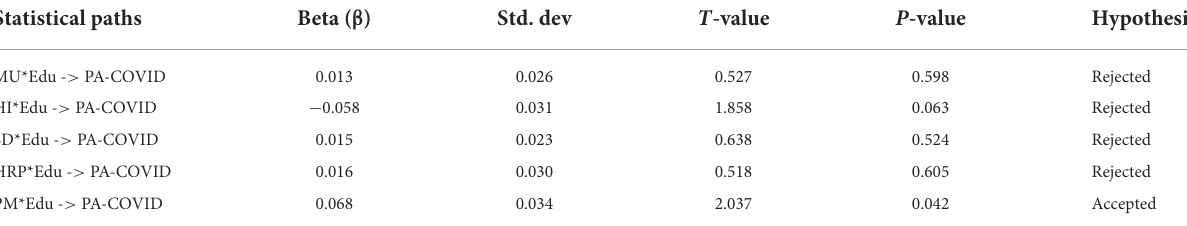
TABLE 5 Moderation effect.